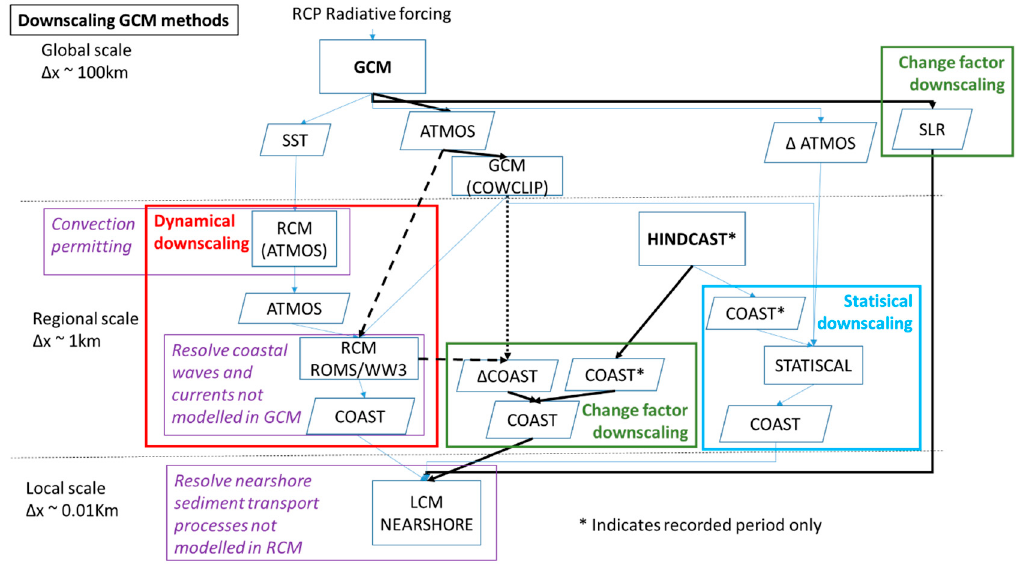
Figure 2. Flow chart of some possible methods for downscaling coastal (COAST) and nearshore (NEARSHORE) wave and current data. Boxed text indicates process (numerical or statistical models) and parallelograms indicated datasets (future and baseline periods). Black arrows indicate the method used in this study, solid for processing both wave and currents, dashed for currents only and dotted for waves only. Blue arrows indicate other possible downscaling methods not used in this study.